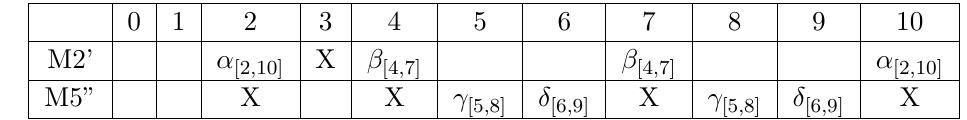
Figure 3 . Schematic view of the M5’ (cid:24) = M5 (cid:18) brane (blue) wrapping the p C x + q C y cycle and M2’ (cid:24) = M2 (cid:11) brane (purple) wrapping the r C x + s C y cycle, in the (cid:28) -torus. The branes intersect j ps (cid:0) qr j times.